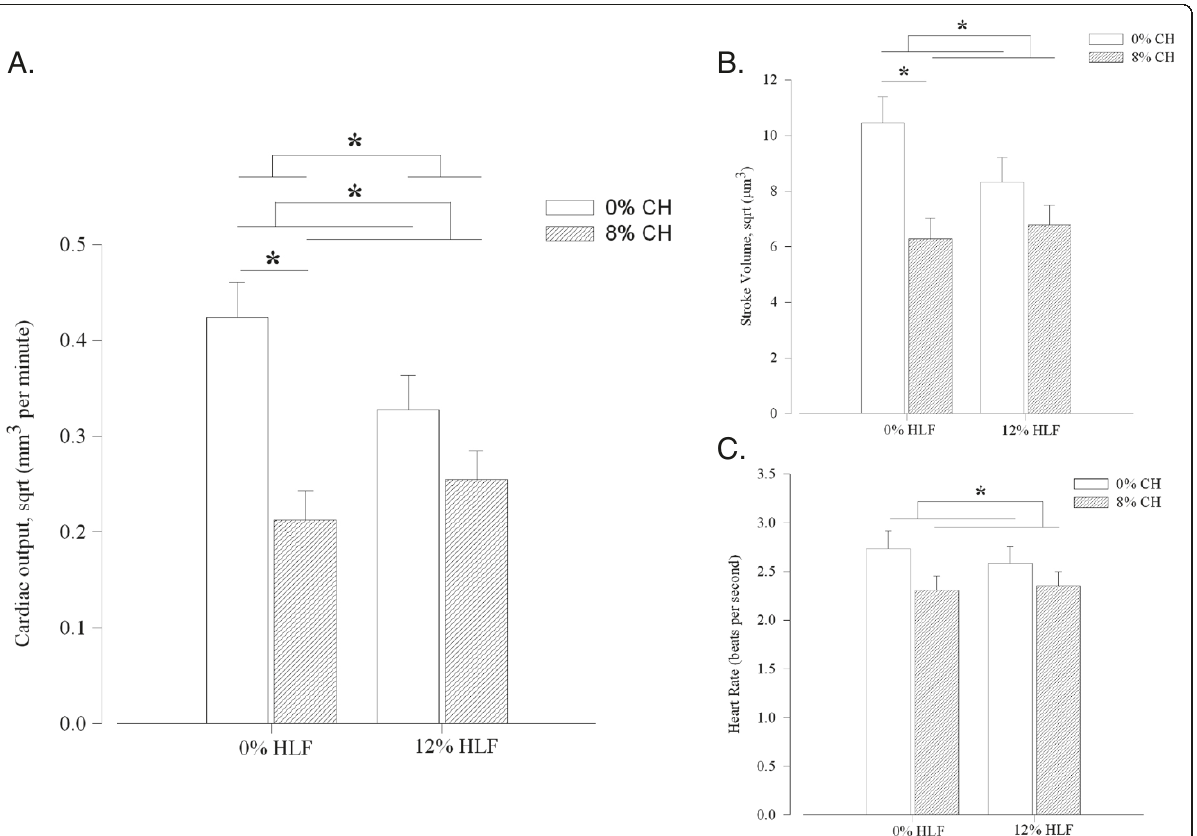
Figure 4 Hawthorn leaves and flowers (HLF) interact with cholesterol (CH) to impact cardiac output (CO). A . HLF show significant interaction with CH in their influence on CO. CH decreases CO within 0% HLF and CH decreases CO when comparing all 0% CH-treated to all 8% CH-treated fish B . No interaction effect was observed on stroke volume (SV). CH decreases SV within 0% HLF and CH decreases SV when comparing all 0% CH-treated to all 8% CH-treated fish C . No interaction effect was observed on heart rate (HR). CH decreases HR when comparing all 0% CH-treated to all 8% CH-treated fish. * P<0.05, bars are mean+S.D. 2-way ANOVA with Holm-Sidak post-hoc analysis. n=12-19 per